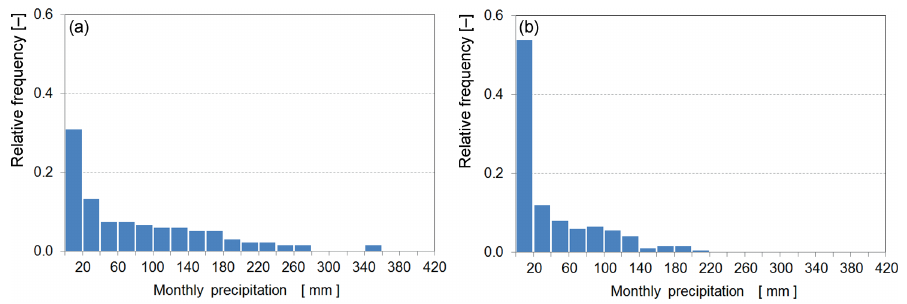
Figure 1. Histogram from the times series of observed monthly precipitation for two random stations: “Laingsnek”, x 57 with z = 81 . 3mm (a) and “Tambotieboom”, x 29 with z = 38 . 3mm (b)